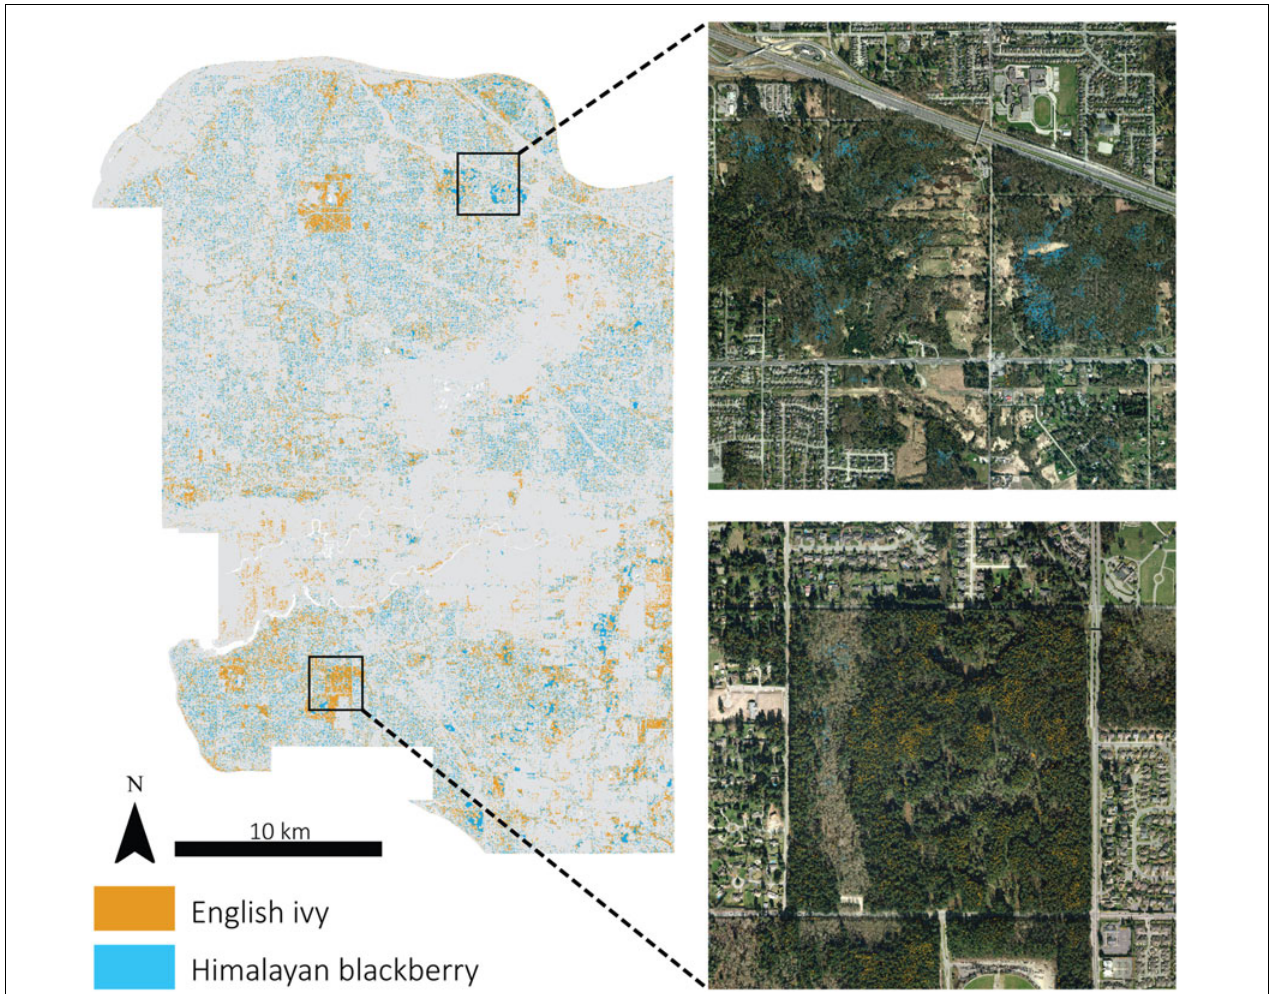
FIGURE 6 | Detected locations of Himalayan blackberry ( Rubus armeniacus ) and English ivy ( Hedera helix ) across Surrey, BC, Canada displayed with a 7 m filter and subsets with actual detected areas.